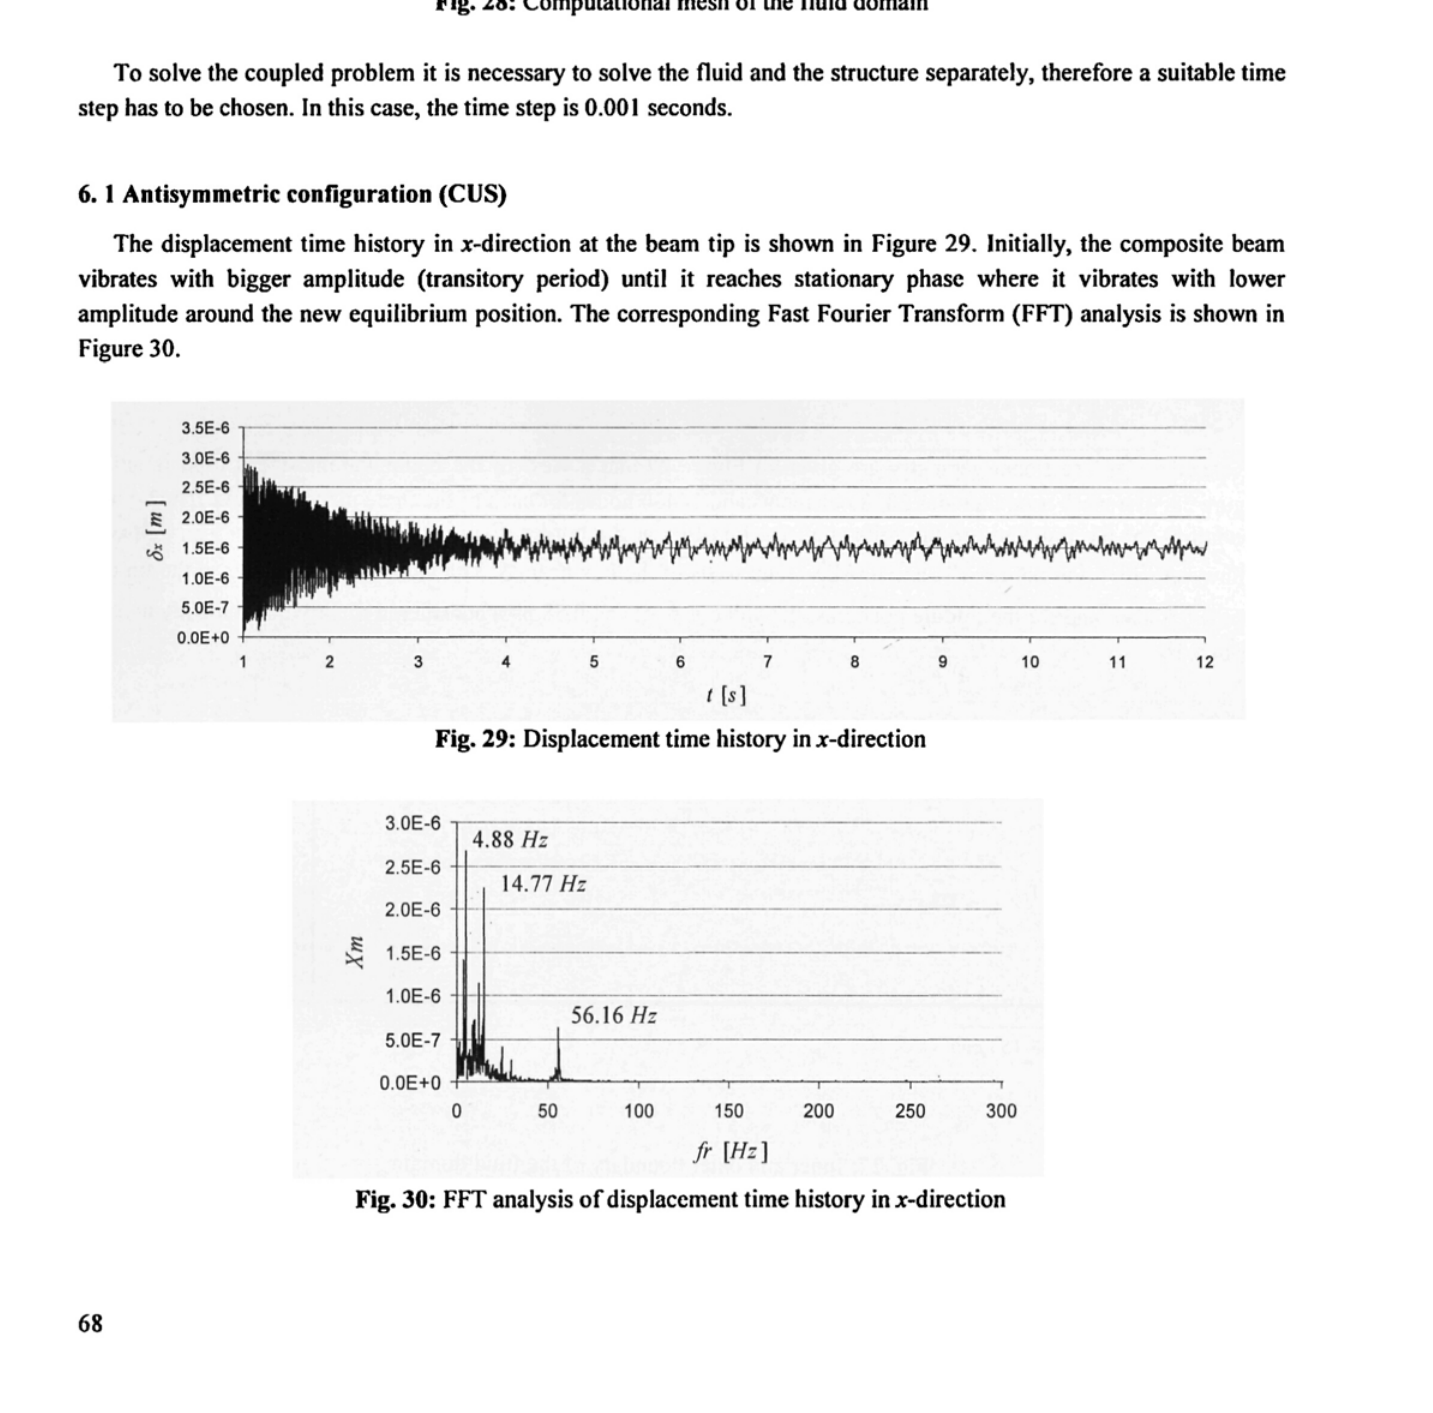
Fig. 28: Computational mesh of the fluid domain